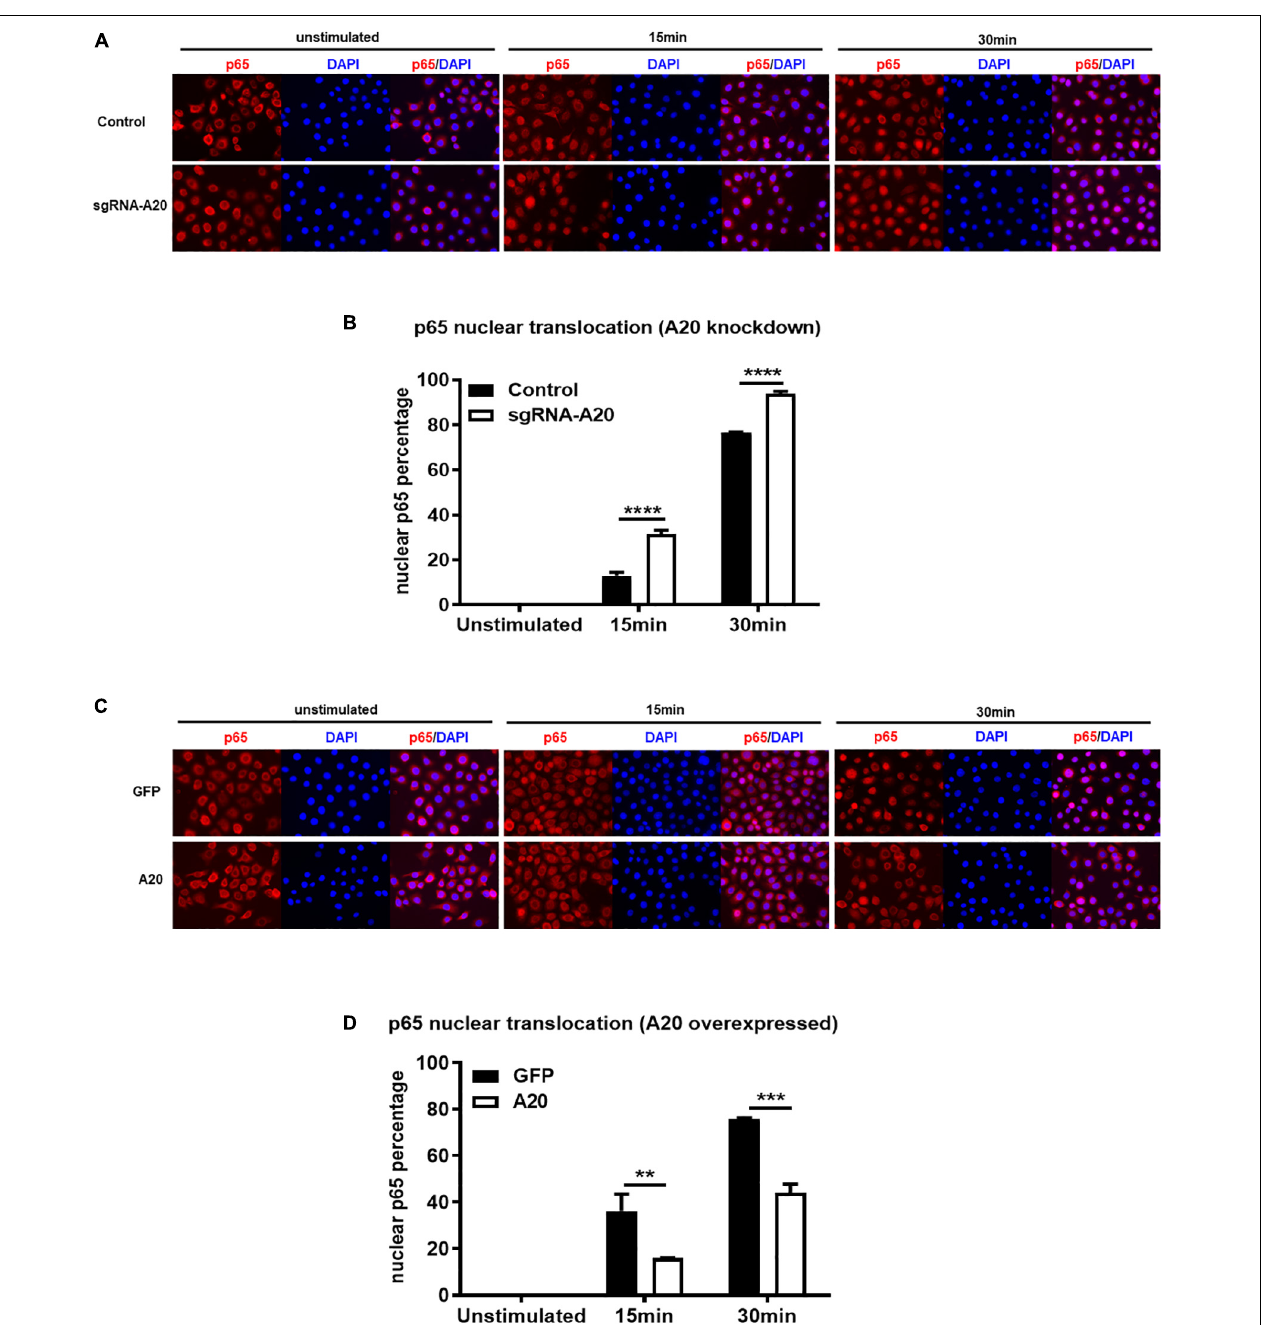
FIGURE 5 | A20 diminishes p65 nuclear translocation in response to P. gingivalis infection in TIGKs. Immunofluorescence of p65 in TIGKs with altered A20 expression or control cells infected with P. gingivalis . p65 were stained with p65 antibody and then Alex-Fluor555 (red) and the nucleus were stained with DAPI (blue). Control or A20 expression altered TIGKs were infected with P. gingivalis (100 MOI) for indicated time courses and images were captured with Axiovent 200M. Representative images of control or A20 depleted TIGKs (A) and the plotted percentage of p65 in the nucleus (B) . Representative images of GFP control or A20 overexpressing TIGKs (C) and the plotted percentage of p65 in the nucleus (D) . Each experiment was performed three times independently and representative experiments were shown. Bar graphs: Values are presented as mean and standard error. ** P ≤ 0.01, *** P ≤ 0.001, and **** P ≤